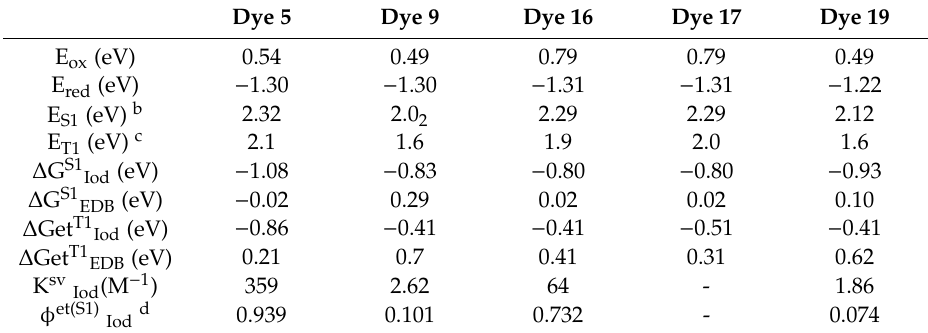
Table 3. Parameters characterizing the chemical mechanisms associated with dyes 5 , 9 , 16 , 17 , 19 in acetonitrile a .